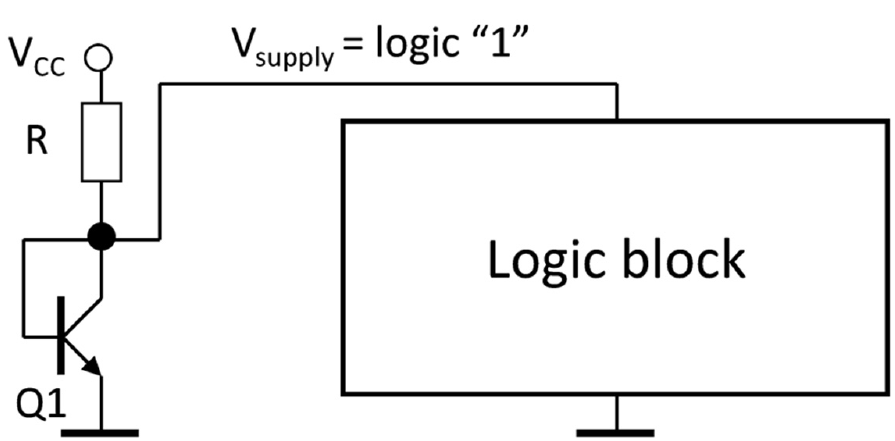
Figure 11. Thermally stabilized logic block.